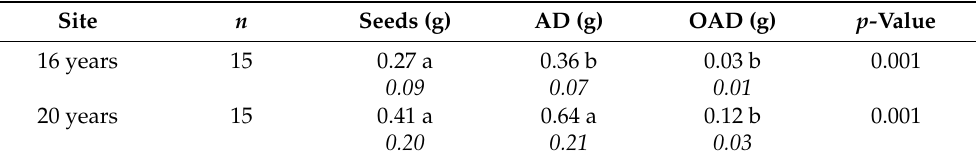
Figure 2. Biomass (g) of three item types found in 15 coal mine refuse piles colonized by P. fallax in 16-year and 20-year rehabilitated sites of the Cerrej ó n mine in La Guajira, Colombia. AD = arthropod debris; OAD = other animal debris. Table 1. Mean and standard error (SE, given in italics) of organic debris found in refuse piles of P. fallax determined by the Kruskal–Wallis test and post hoc comparisons using the Dunn test. Different letters denote statistically significant differences between study sites. n = number of nests; AD = arthropod debris; OAD = other animal debris.